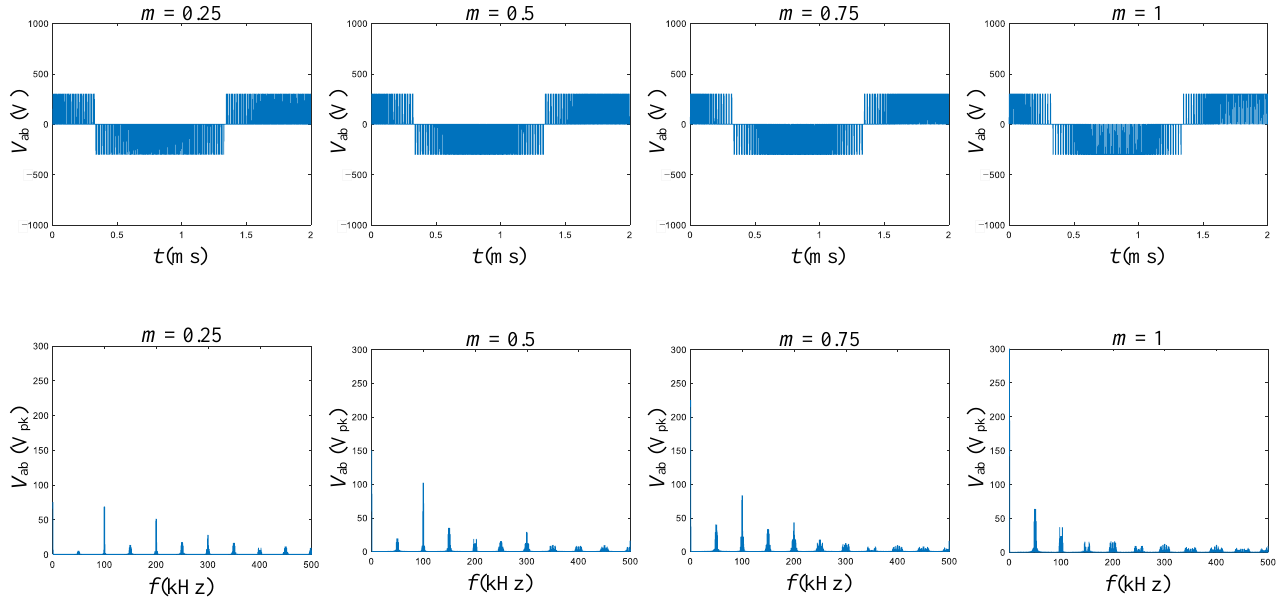
Figure 6. Time-domain and frequency-domain plots of the motor line-to-line voltage in EV 1 under four different modulation index values. Designs A and B.